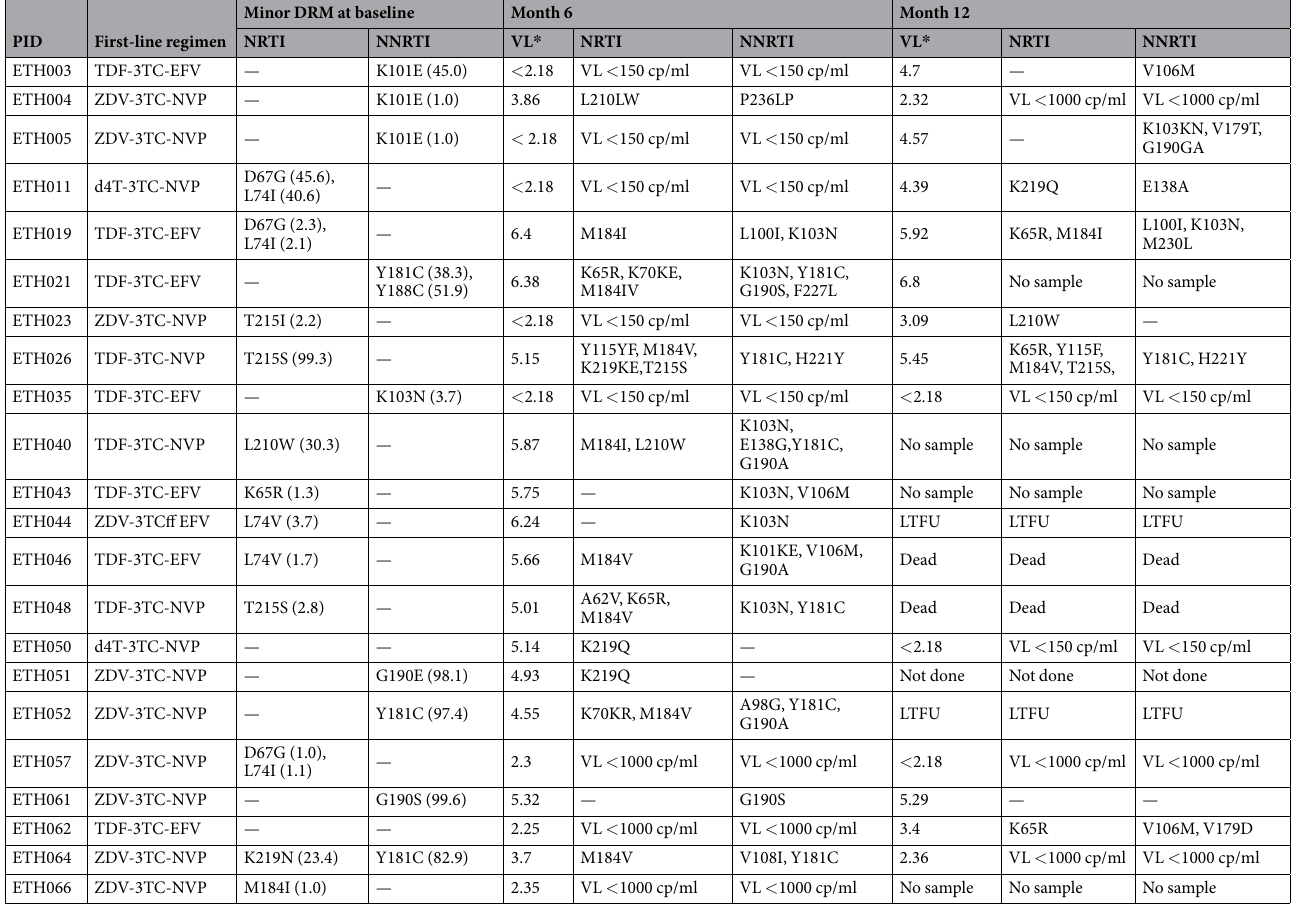
Table 4. Surveillance drug resistance mutations associated with reverse transcriptase inhibitors identified by